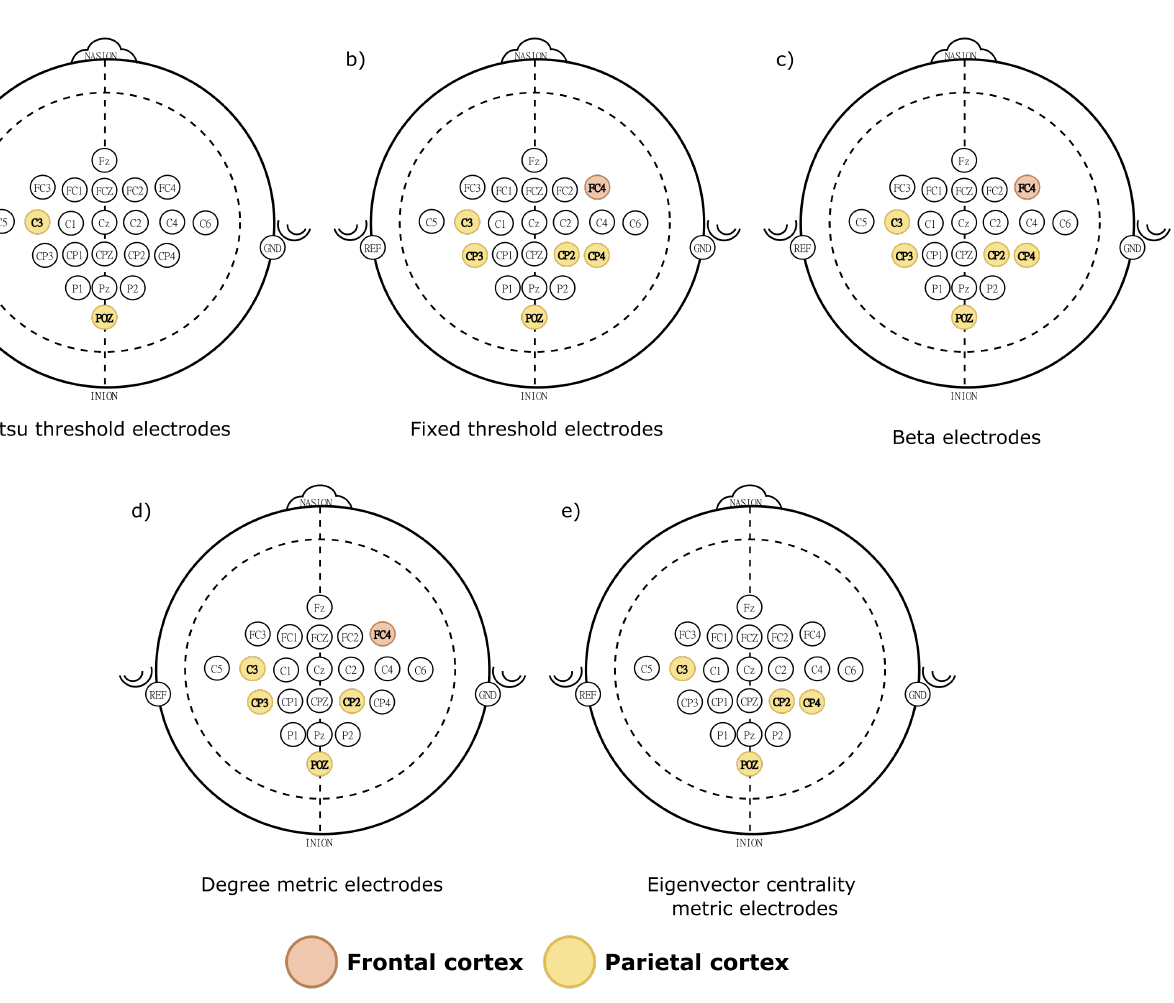
Figure 7. The electrodes with significative differences according to the post hoc MANOVA. In ( a ) all electrodes obtained with the post hoc analysis; ( b , c ) display the significative electrodes for the single-layer metrics with significative differences, while ( d , e ) identify the electrodes that were significative for both